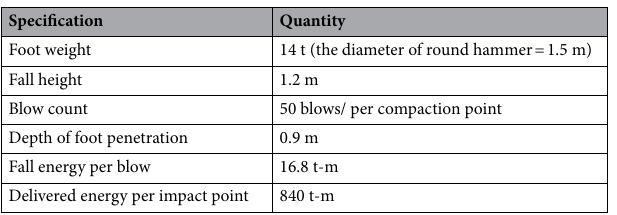
Table 2. RIC equipment and compaction information.